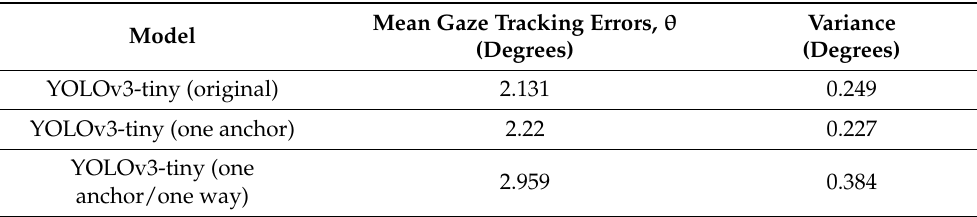
Figure 16. ( a ) Four target markers used for calibration for the training mode. ( b ) Five target points used for estimation for the testing mode. Table 8. Comparisons of gaze tracking errors among the three YOLOv3-tiny-based models for the training mode.